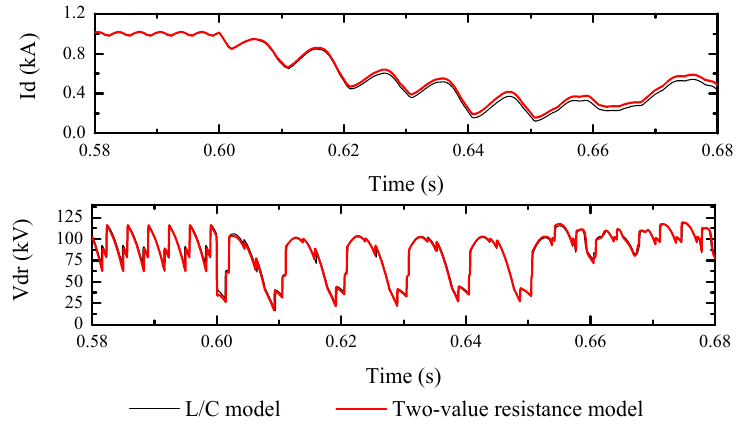
Figure 14. Response of system to a metallic single-line-to-ground fault occurs at the bus of rectifier side. ( Top ) rectifier DC current, ( bottom ) rectifier DC voltage (Case 4).